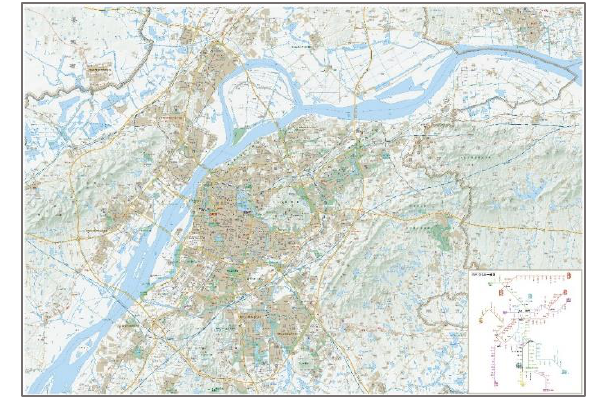
Figure 8. The city map of Wuhan in Hubei